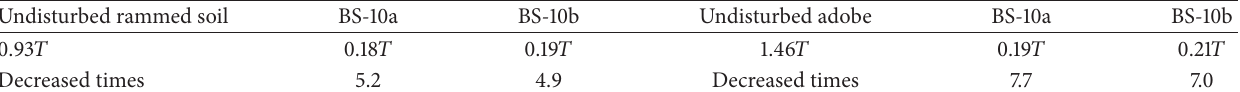
Table 8: Wind erosion amount of soil samples before and after BS-10 consolidation in the natural wind erosion in Turpan.